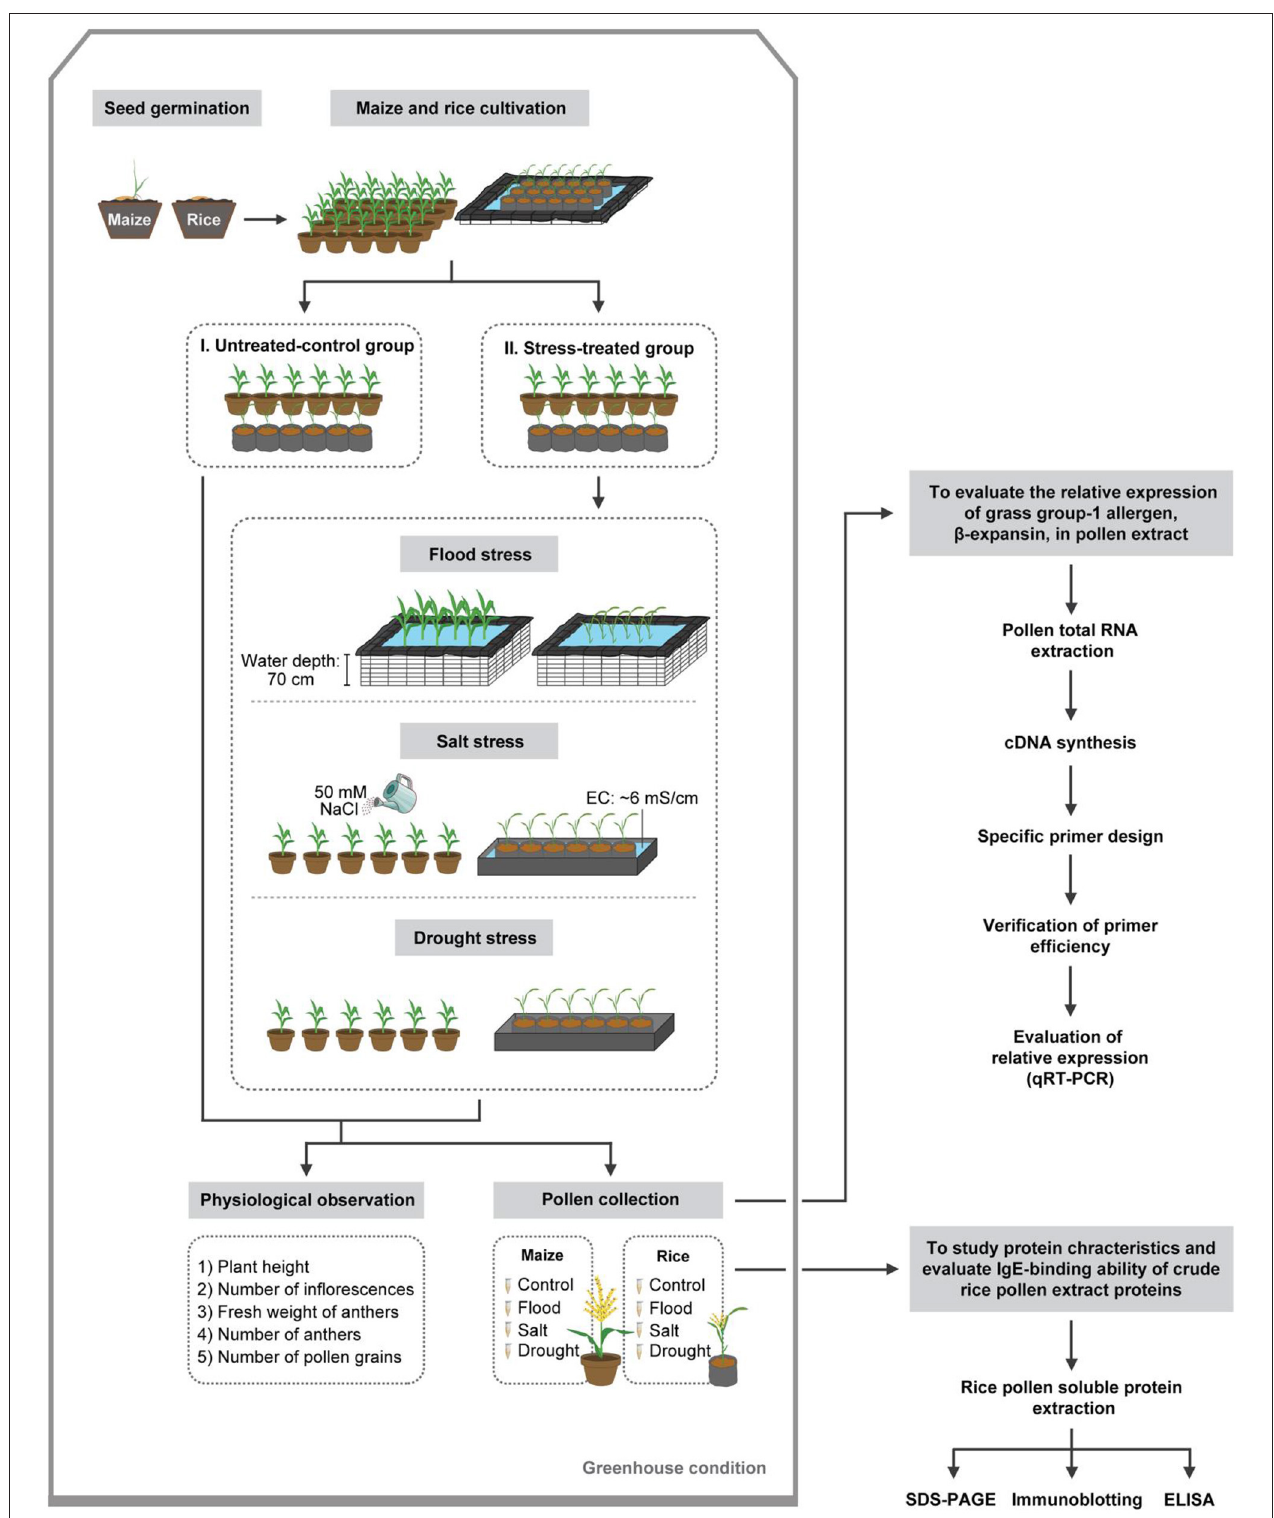
FIGURE 1 | Schematic overview of experimental methods.